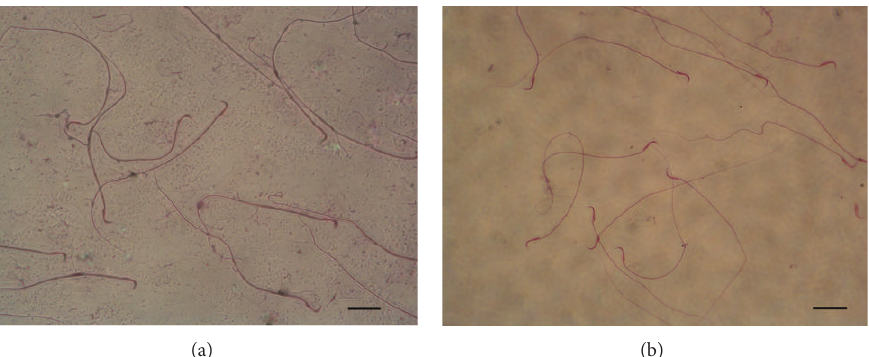
Figure 1: Diff-quick staining of sperm cells. (a) Sperm cells isolated from healthy male rats; (b) sperm cells isolated from healthy male rats; H&E staining, magnification 40x, scale bar: 125 𝜇